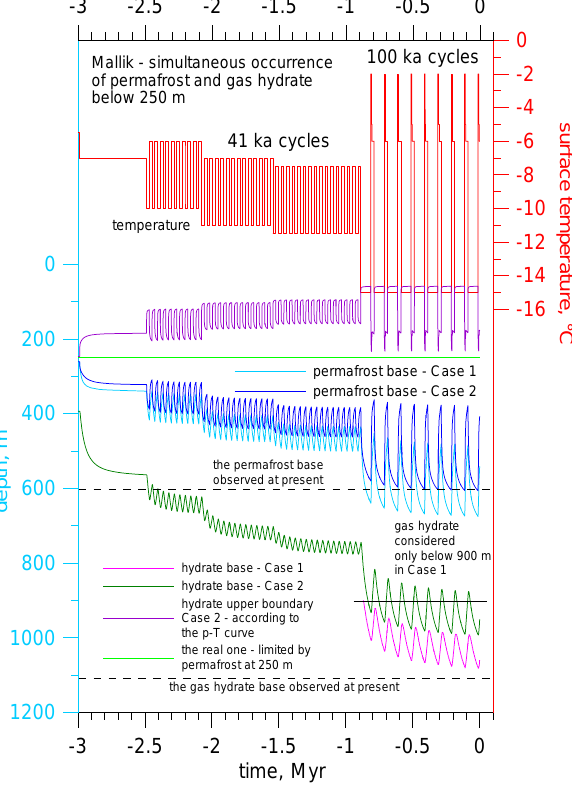
Fig. 9. Details from Fig. 8 of the IBP and GH upper and lower Fig. 9. Detail, from Figure 8, of the IBP and GH upper and lower boundaries for the last 3 Myr before the Present. boundaries for the last 3Myr before the present.